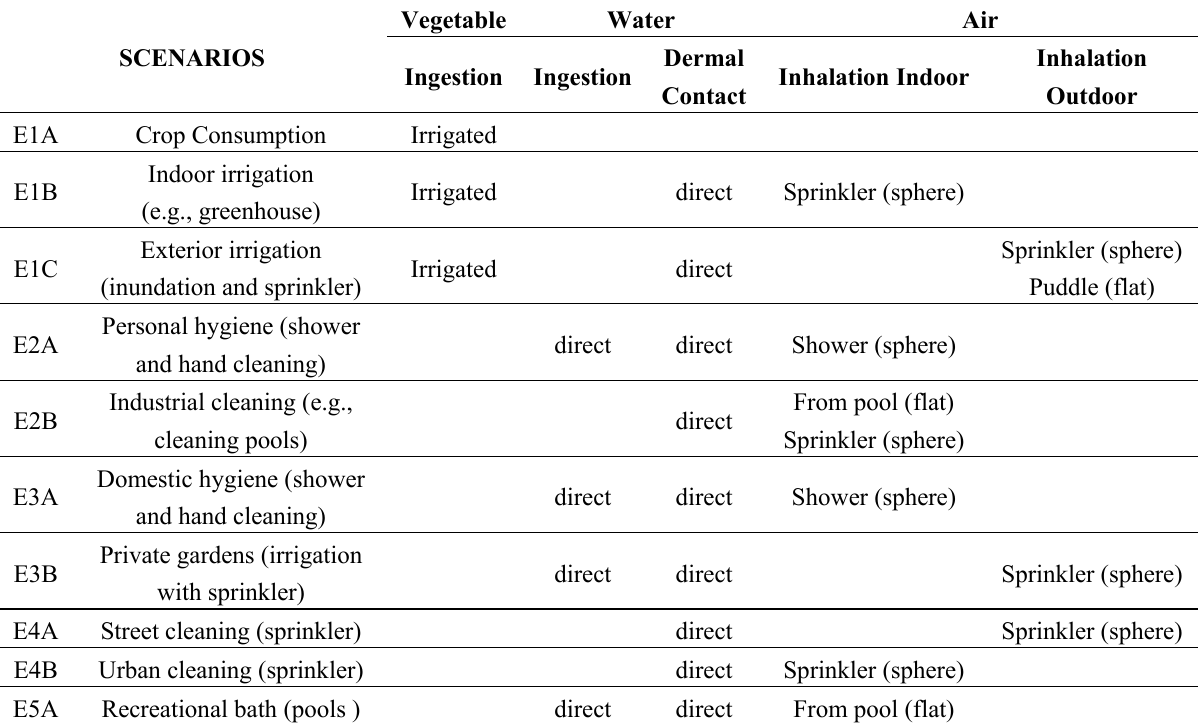
Table 3. The pathways included in all of the scenarios considered.